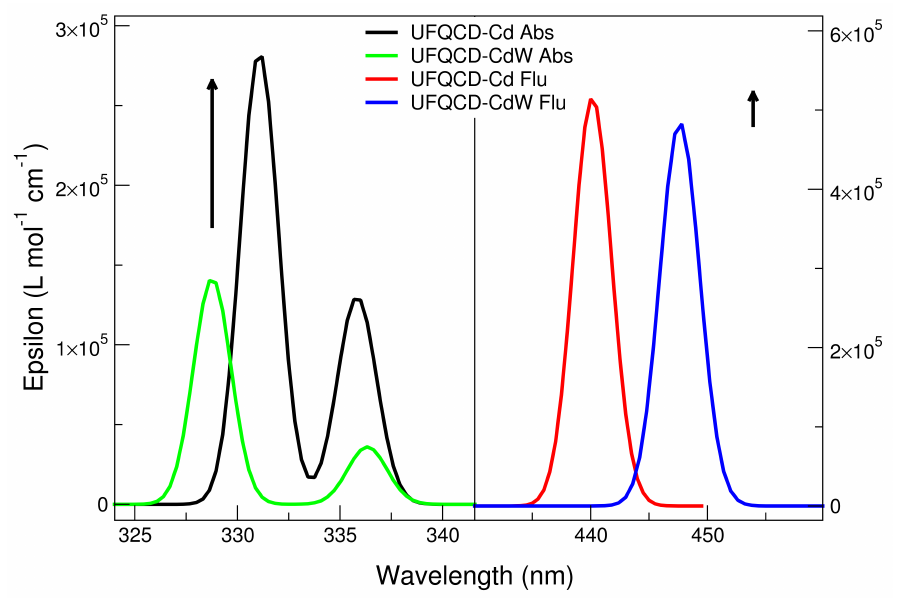
Figure 6. UFQD-Cd absorption ( left panel ) and UFQD-Cd emission ( right panel ) theoretical spectra.